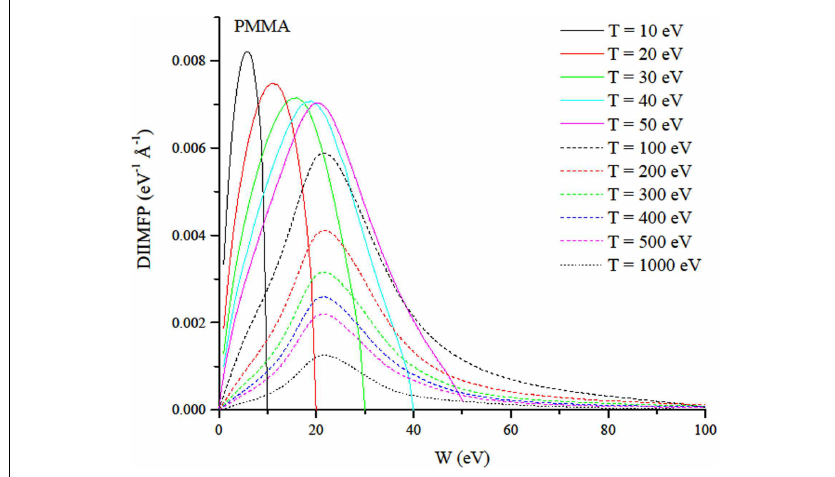
FIGURE 1 | Mermin DIIMFP of electrons in PMMA for selected values of the incident electron kinetic energy T in the range 10–1000eV